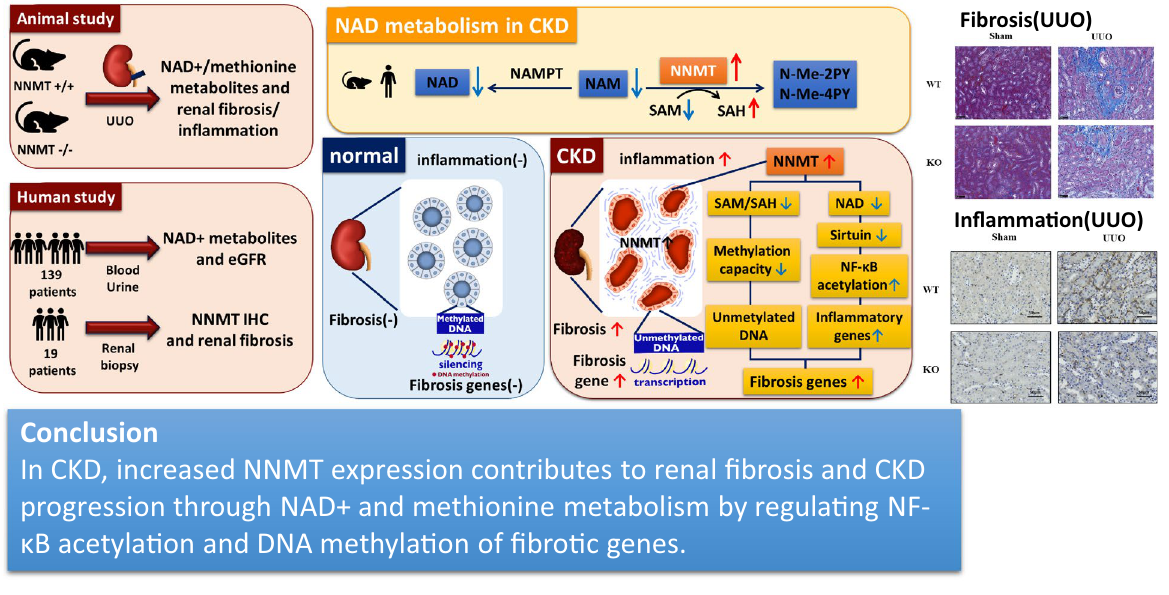
Figure 8. Graphical abstract of this study. In CKD, increased NNMT expression contributes to renal fibrosis and CKD progression through NAD + and methionine metabolism by regulating NF-κB acetylation and DNA methylation of fibrotic genes. UUO, unilateral ureter obstruction; NAM, nicotinamide; NAD + , nicotinamide adenine dinucleotide; NAMPT, nicotinamide phosphoribosyltransferase; NNMT,